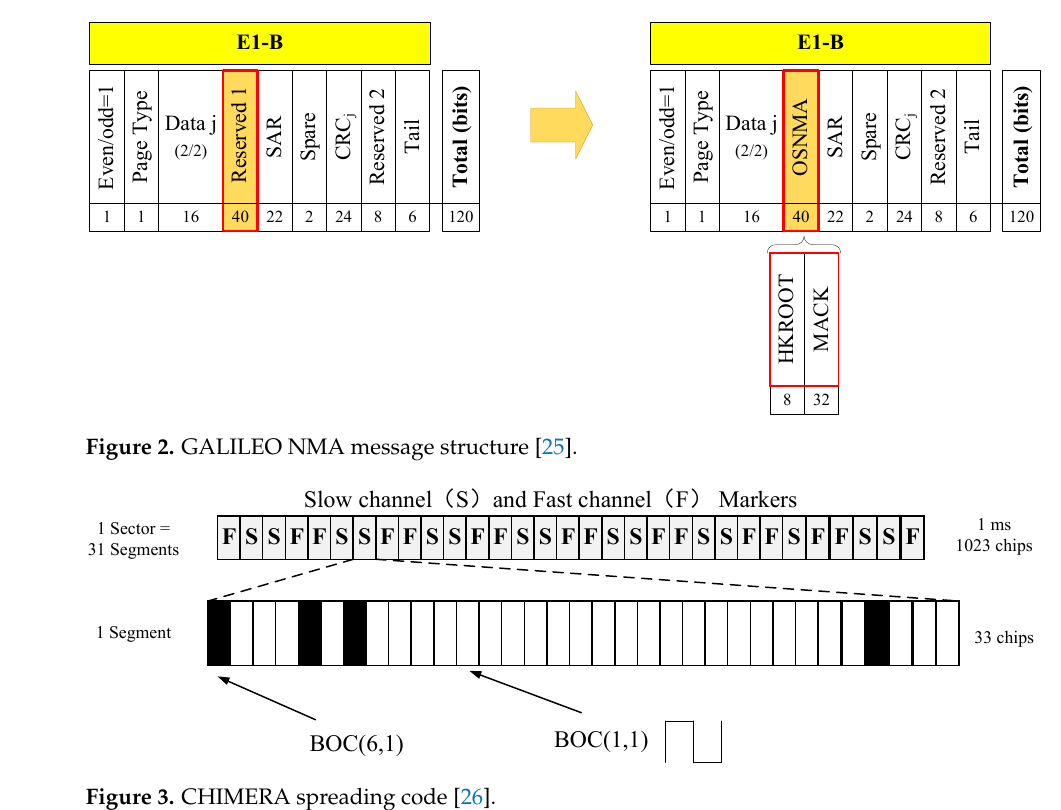
Table 1. Comparison of NMA and SCA.